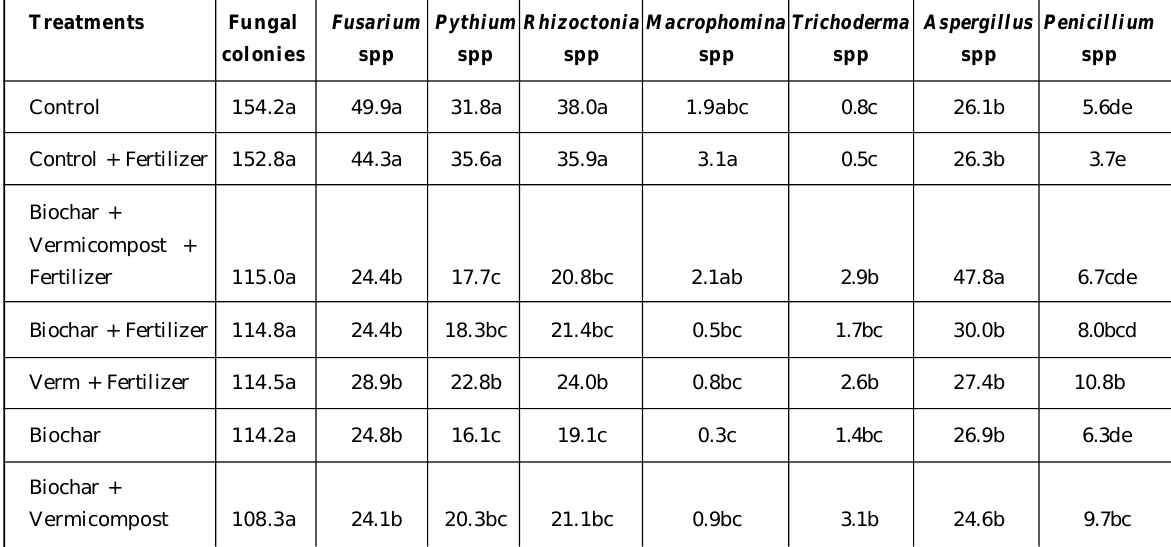
Table 8: Effect of biochar and vermicompost on fungal populations ( × 10 3 CFU/g soil) six weeks after planting common bean in the long rains season of 2013